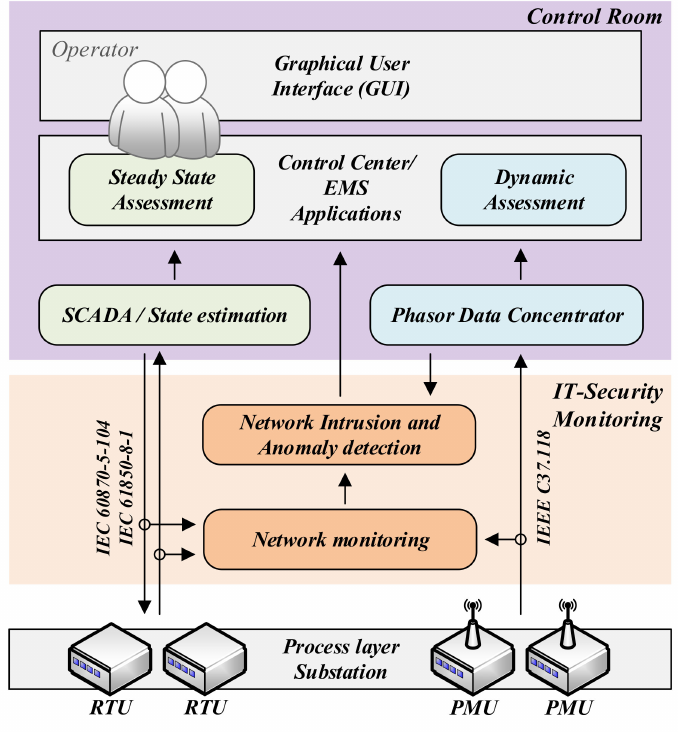
Figure 1. Basic concept of a cyber-secure dynamic control center